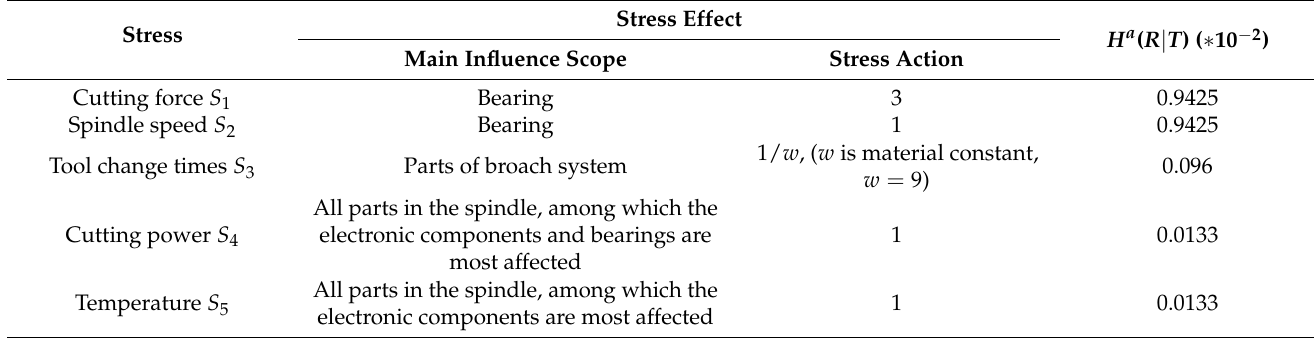
Table 7. Factors affecting the importance of stress on the motorized